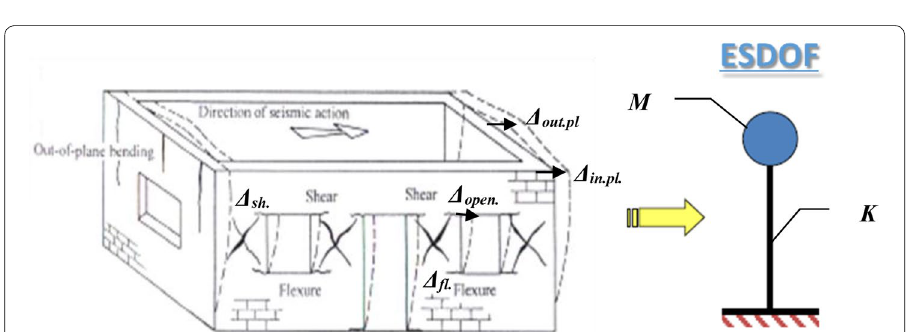
reinforced concrete, = two-story =